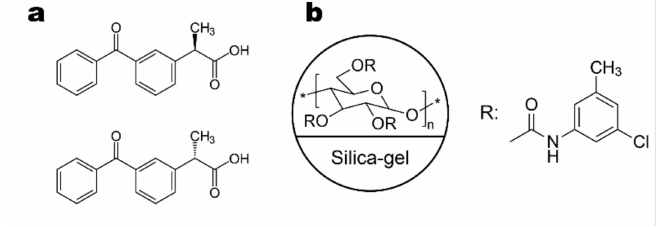
Figure 1. Structure of ketoprofen ( a ) and chiral selector ( b